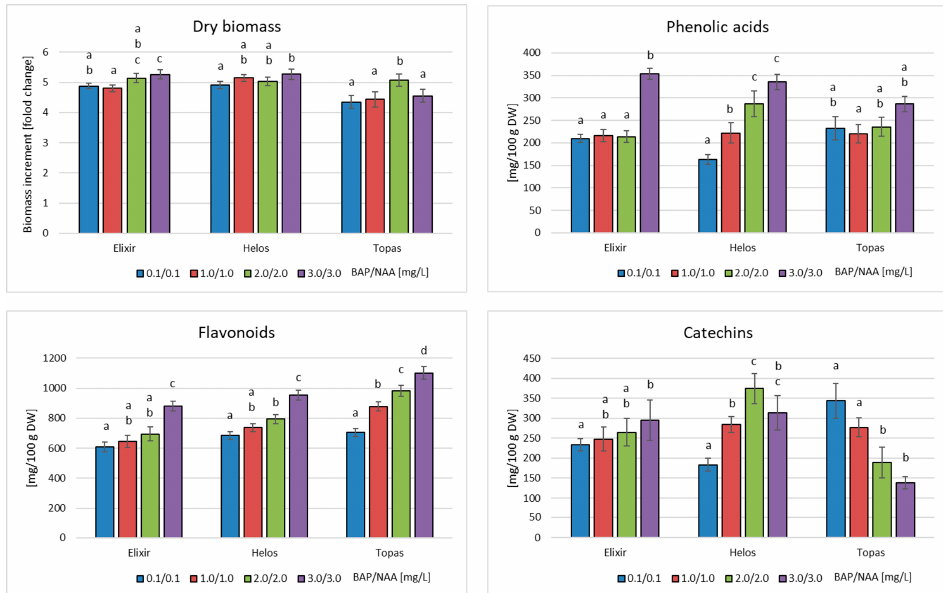
Figure 3. Microshoot in vitro culture of H. perforatum cv. Helos in the temporary immersion sys- tem (TIS): PlantForm bioreactors after a four-week growth cycle in a MS medium variant supple- mented with 1.0 mg/L BAP and 1.0 mg/L NAA.